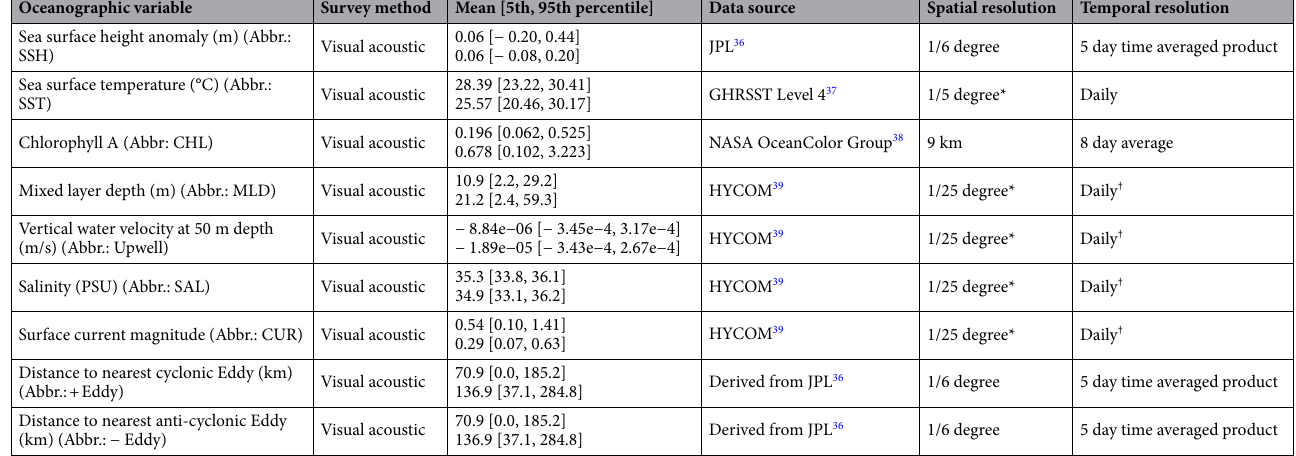
Table 1. Comparison of environmental variability observed in the visual survey and PAM datasets. Asterisks (*) indicate spatially interpolated products, and obelisks (†) indicate products which are seven day